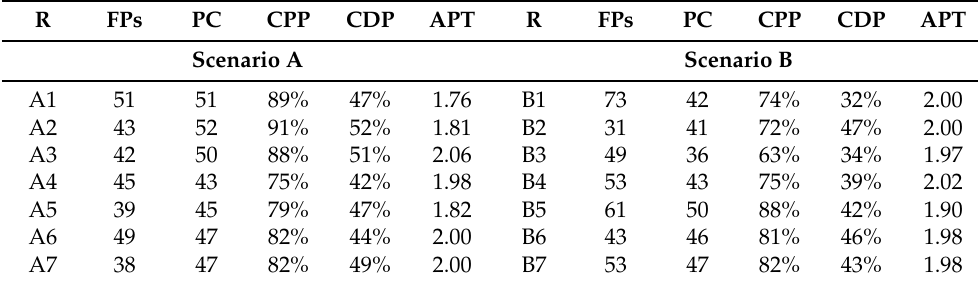
Table 5. Two MS results. Legend: R—Run; FPs—False Positives; PC—Predicted Collisions;